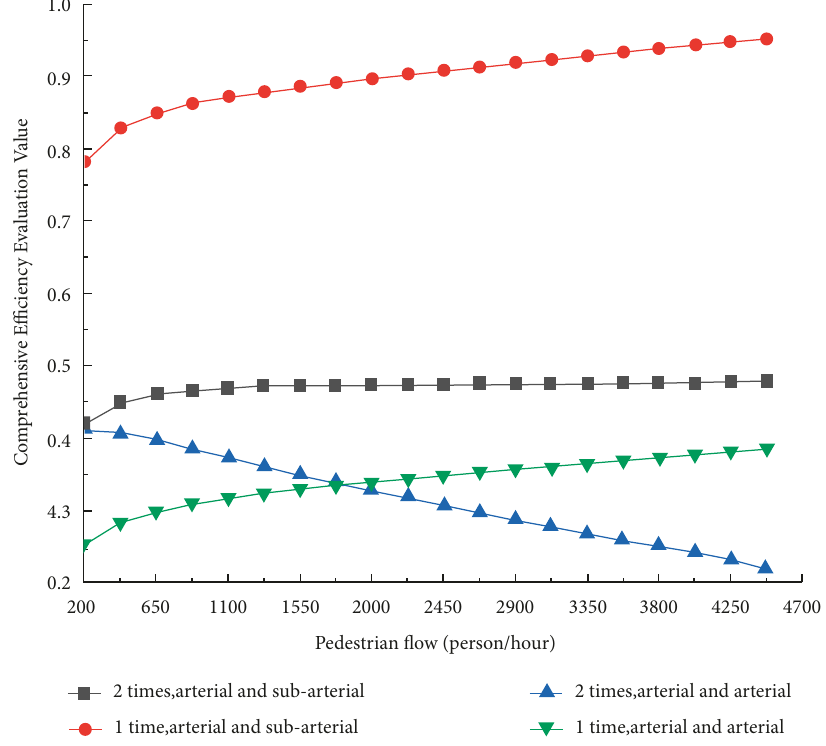
Figure 15: Relationship between comprehensive efficiency evaluation value and pedestrian flow